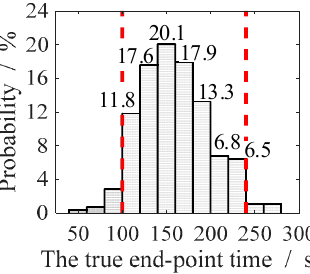
Figure 6. Distribution of the true end-point